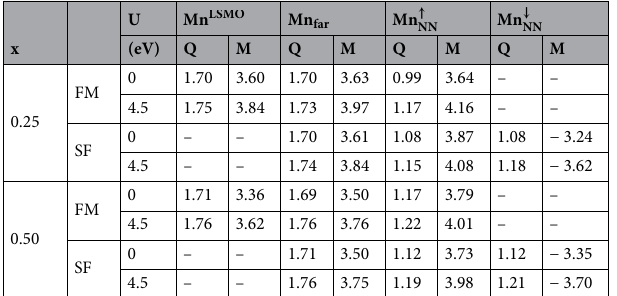
Table 1. Summarized data for high vacancy concentration in LSMO with different Sr concentration (x): formation energy ( E for ) with ground state energy highlighted in bold, interatomic distance between Mn nearest neighbors to the vacancy ( d Mn-Mn ) and total magnetic moment change ( (cid:31) M) between defective and pristine systems. GGA + U results correspond to U = 4.5eV . As a reference, the average Mn-Mn distance for pristine LSMO is marked with an asterisk. Superscript OL (UL) stands for occupied (unoccupied) defect level.